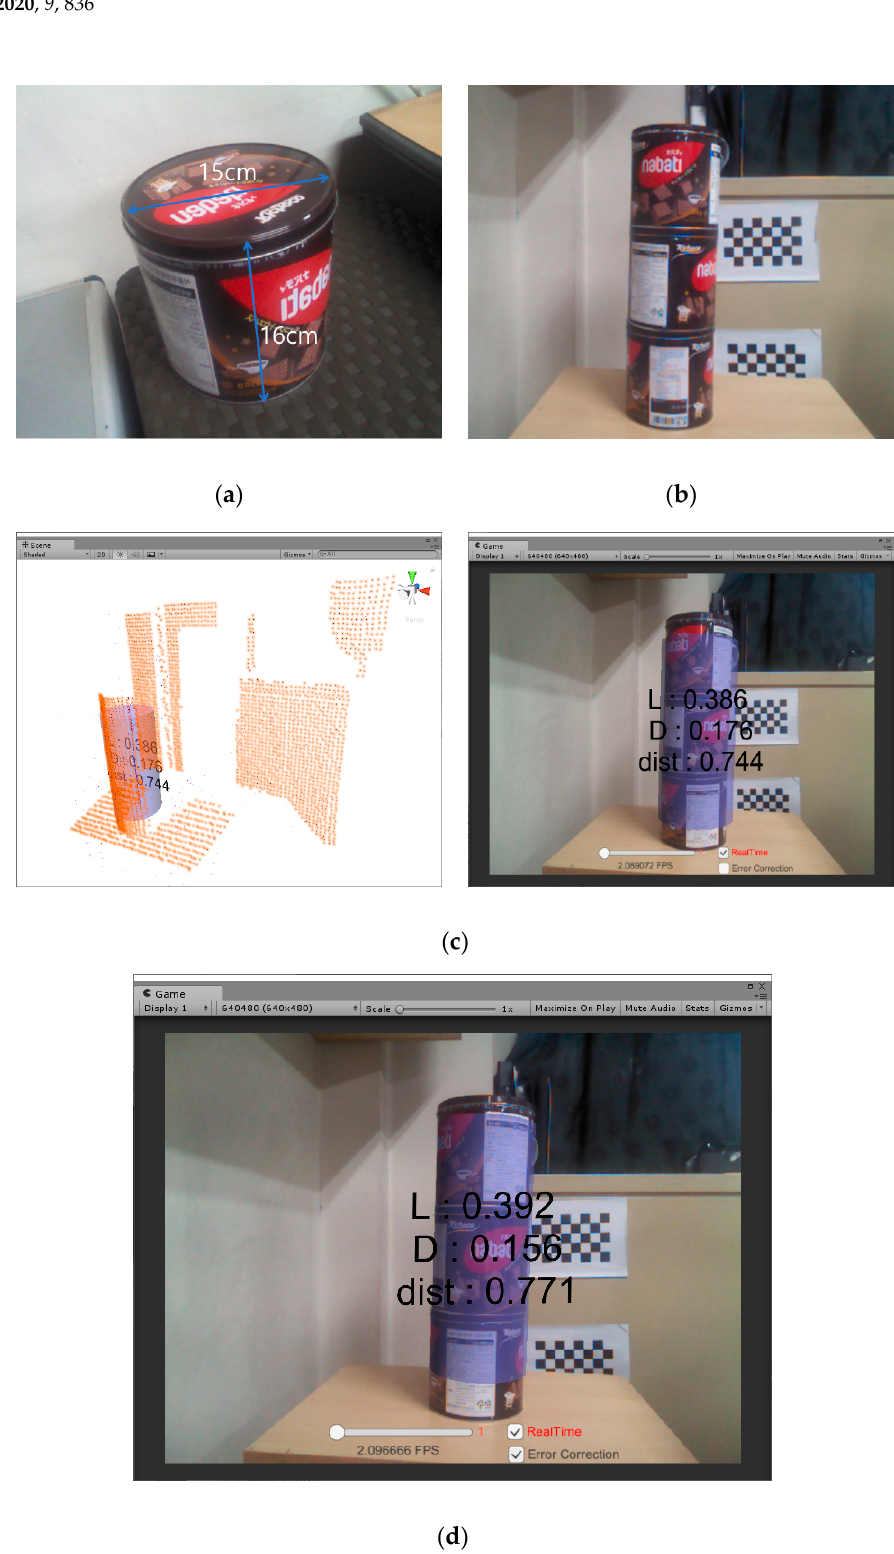
( b ) Figure 12. Point data scale k times for estimation 𝛜 = 25: ( a ) the default scale; ( b ) the k times scale. 3. Results and Discussions 3.1. Cylinder Estimation Using Kinect V1 Real-time estimation of the depth images in Section 2.2 used Kinect V1 and RealSense SR300. The data is composed as shown in Figure 13b by sampling about 15% from the depth image with a 640 × 480 resolution. As shown in Figure 13a, the cylinders used for the experiment were constructed using three cans